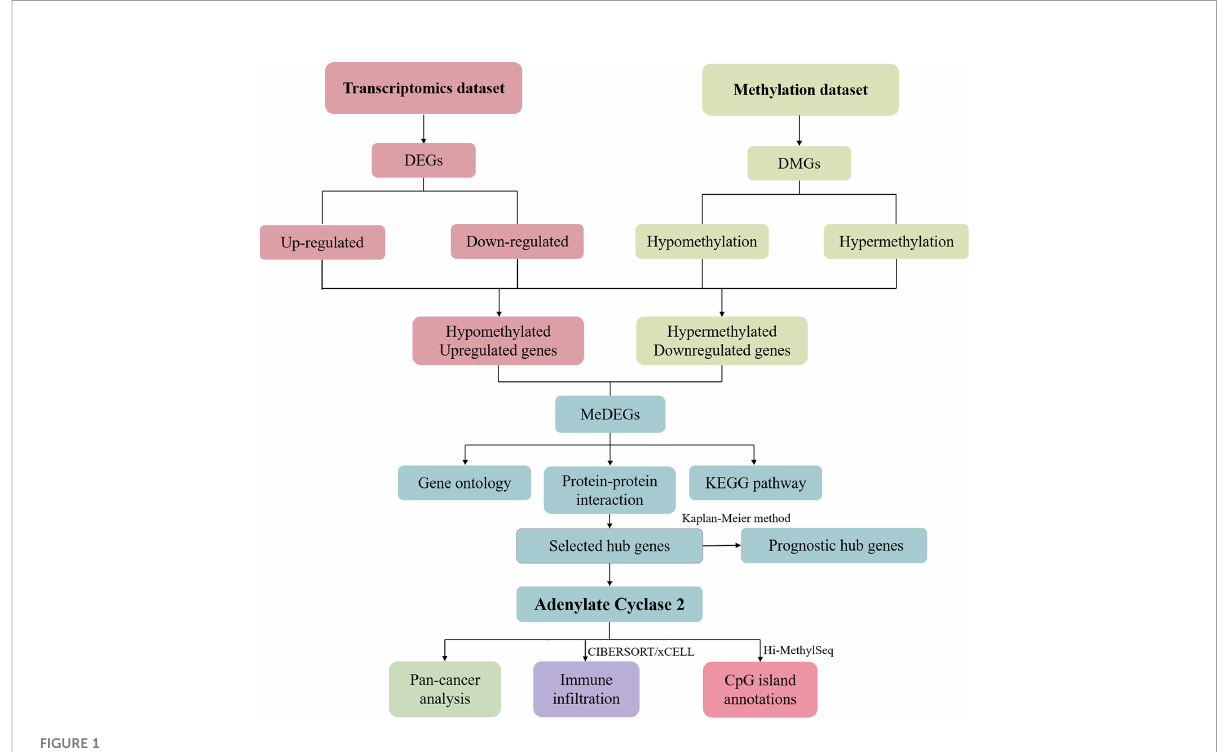
FIGURE 1 Schematic diagram of the